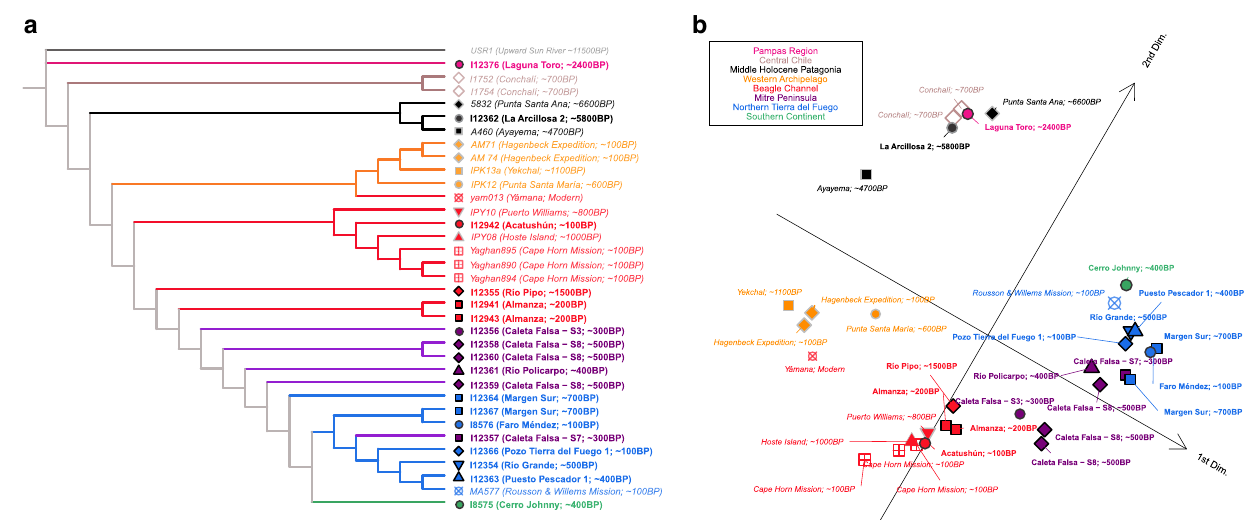
Fig. 2 Population structure in South Patagonia. a Neighbor-joining tree created using the matrix of inverted statistics ( f 3 (Mbuti; Ind1, Ind2) ) − 1 , with an ancient Beringian 77 as an outgroup 72, 73 . b Multidimensional scaling (MDS) plot of the matrix of statistics 1- f 3 (Mbuti; Ind1, Ind2) . The matrix of the fi rst two dimensions of MDS was rotated 30 degrees to emphasize the striking geographic correlation of the genetic cline of Late Holocene samples to the coastline. Only individuals with >100,000 SNPs were included; newly and previously reported data are in bold and italics, respectively.